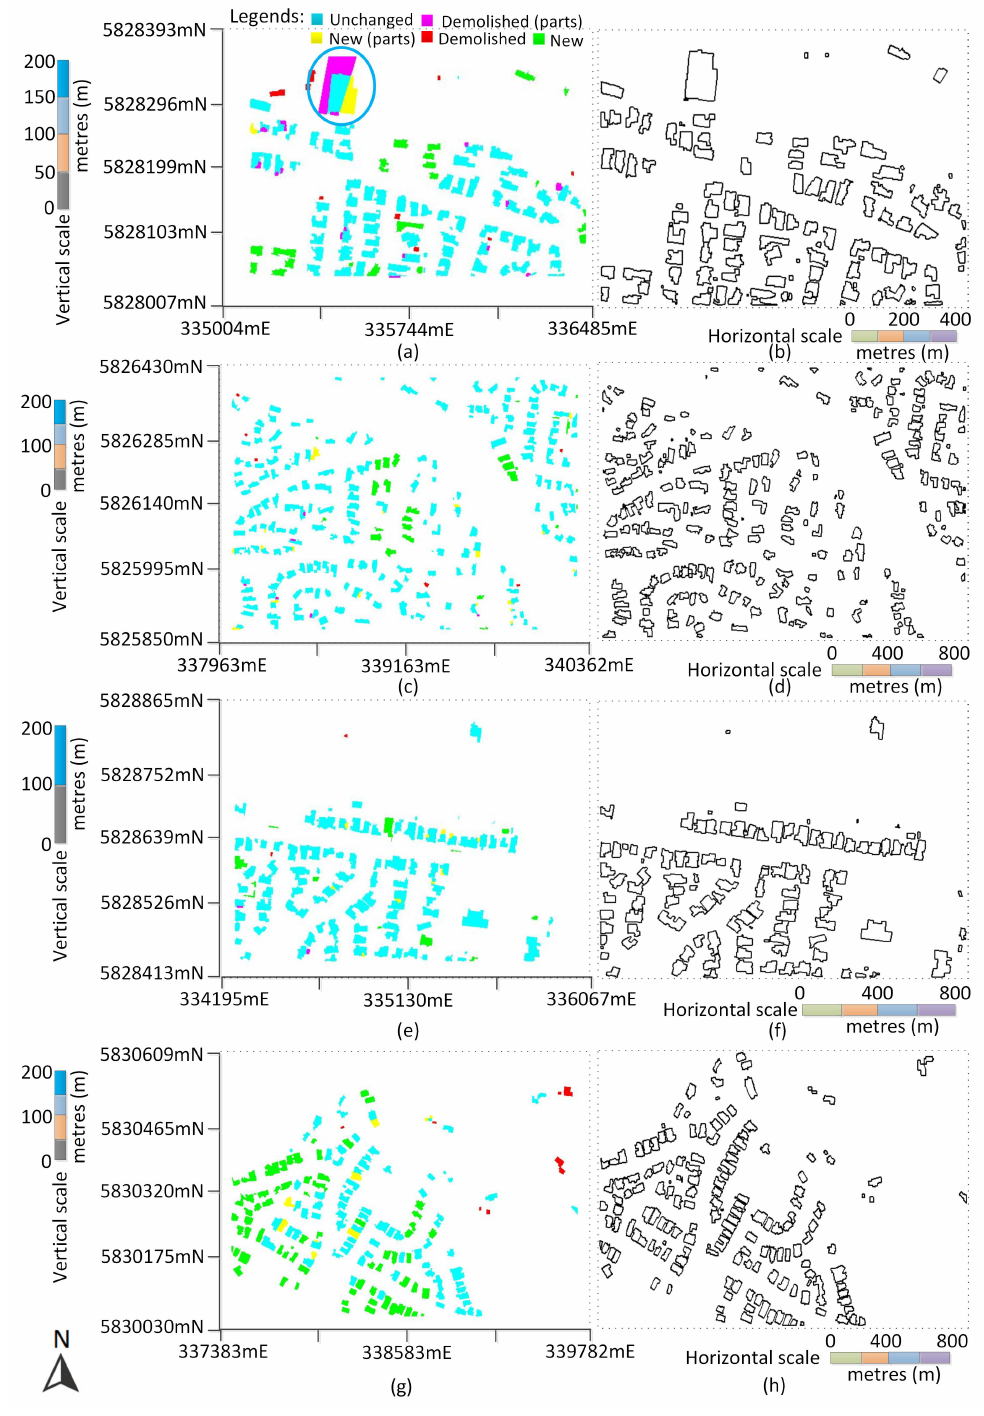
datasets in 2012 (the right column of Figure 6). The left column of Figure 9 depicts the final automatic change detection results (mask M in Section 3.3). 4